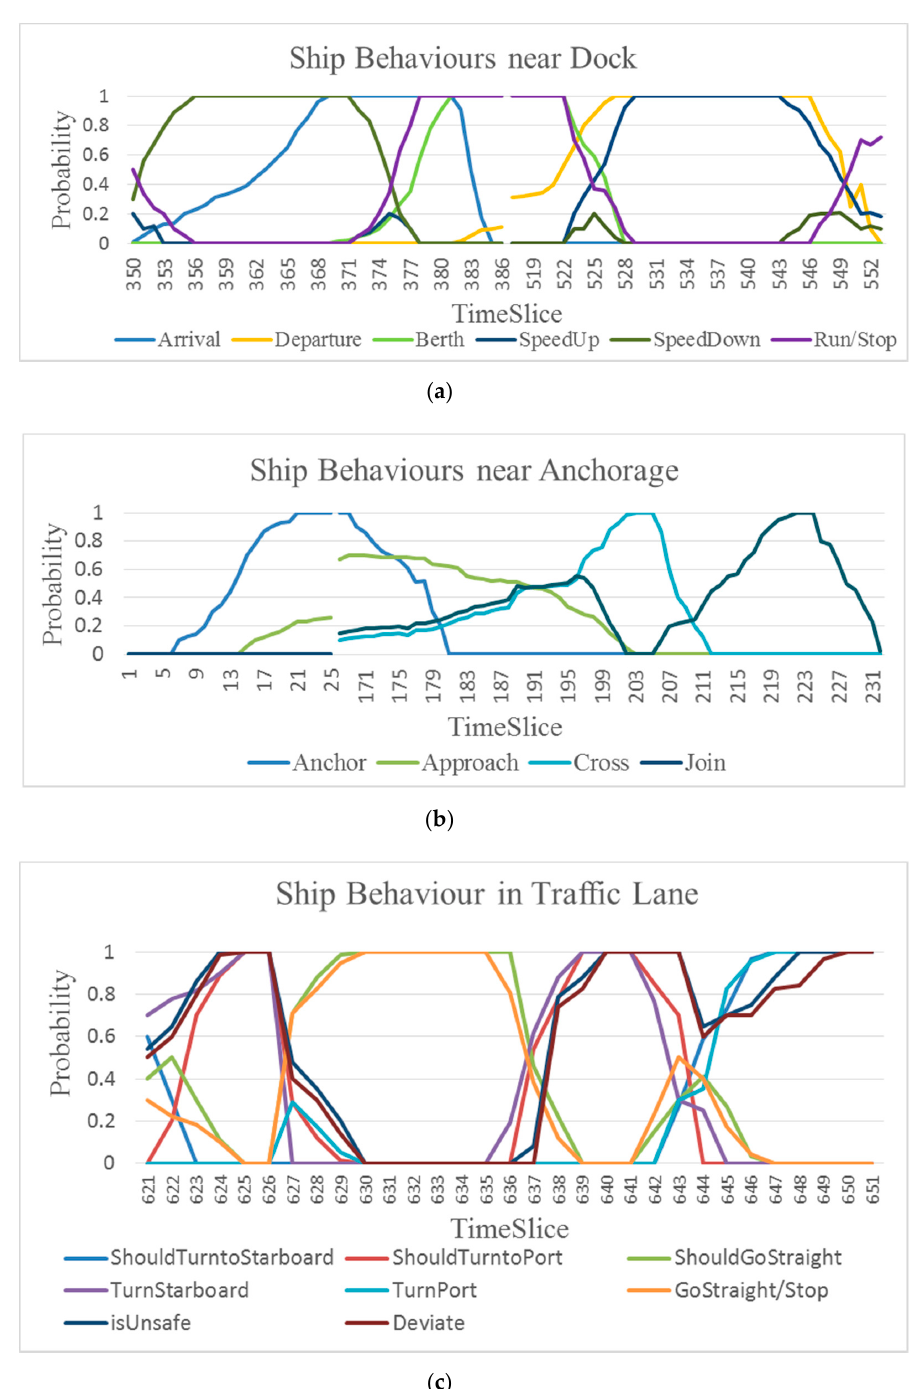
Figure 13. Probability of ship behaviors reasoned by DBN. ( a ) Ship behaviors near dock; ( b ) ship behaviors near anchorage; and ( c ) ship behaviors in traffic lane. In some time periods, the probabilities are almost unchanged because berth in dock and anchor in anchorage, so there are time gaps in the time slices of 25 – 180 and 386 – 516.